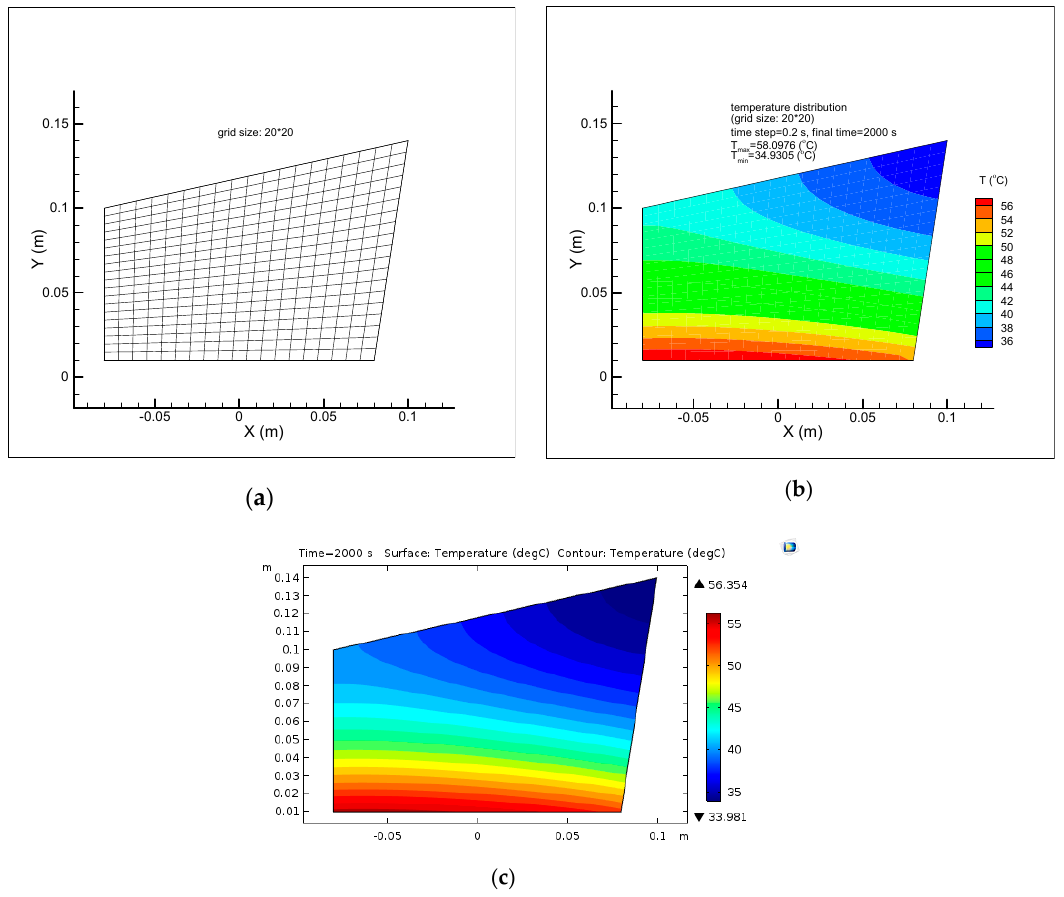
Figure 3. Validation of the direct problem solver using the finite element software COMSOL. The result obtained by using our explicit code ( a , b ), and the result obtained by using COMSOL ( c ).